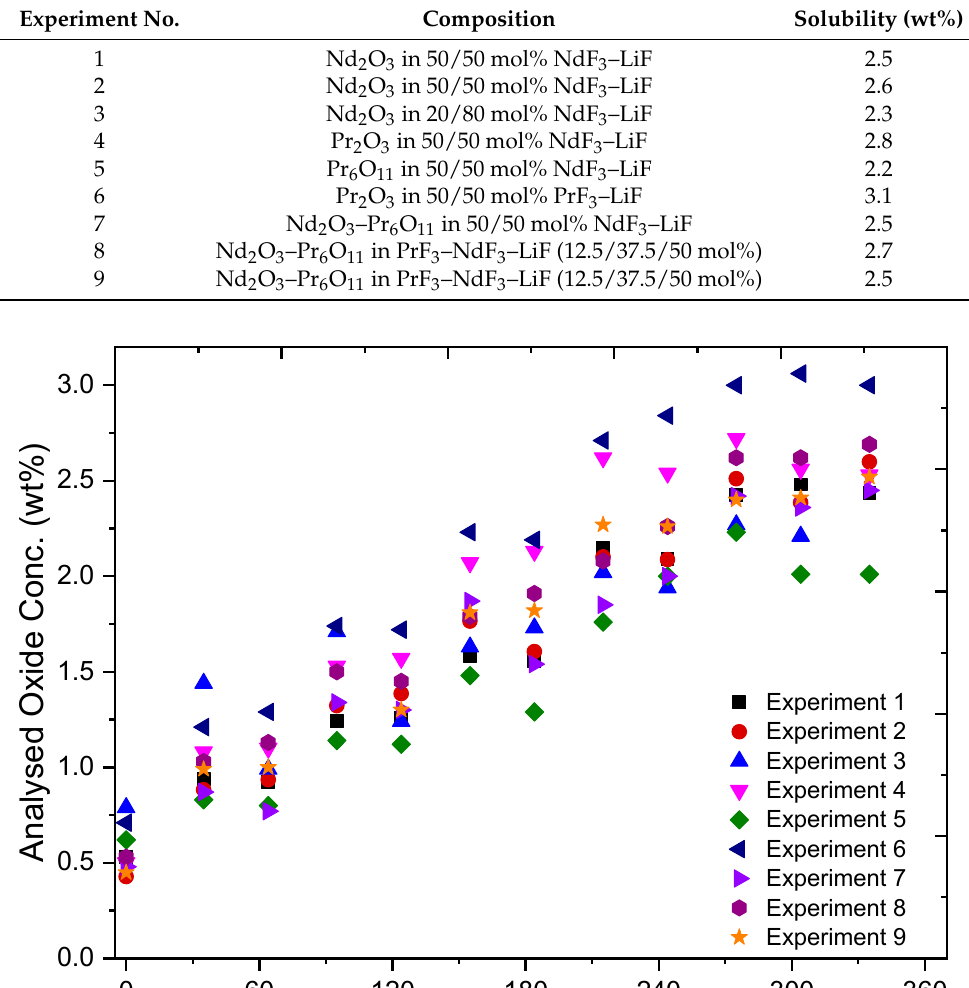
Table 4. Maximum oxide concentration values using the inert gas fusion technique with LECO for the 9 experiments. Experiment No.